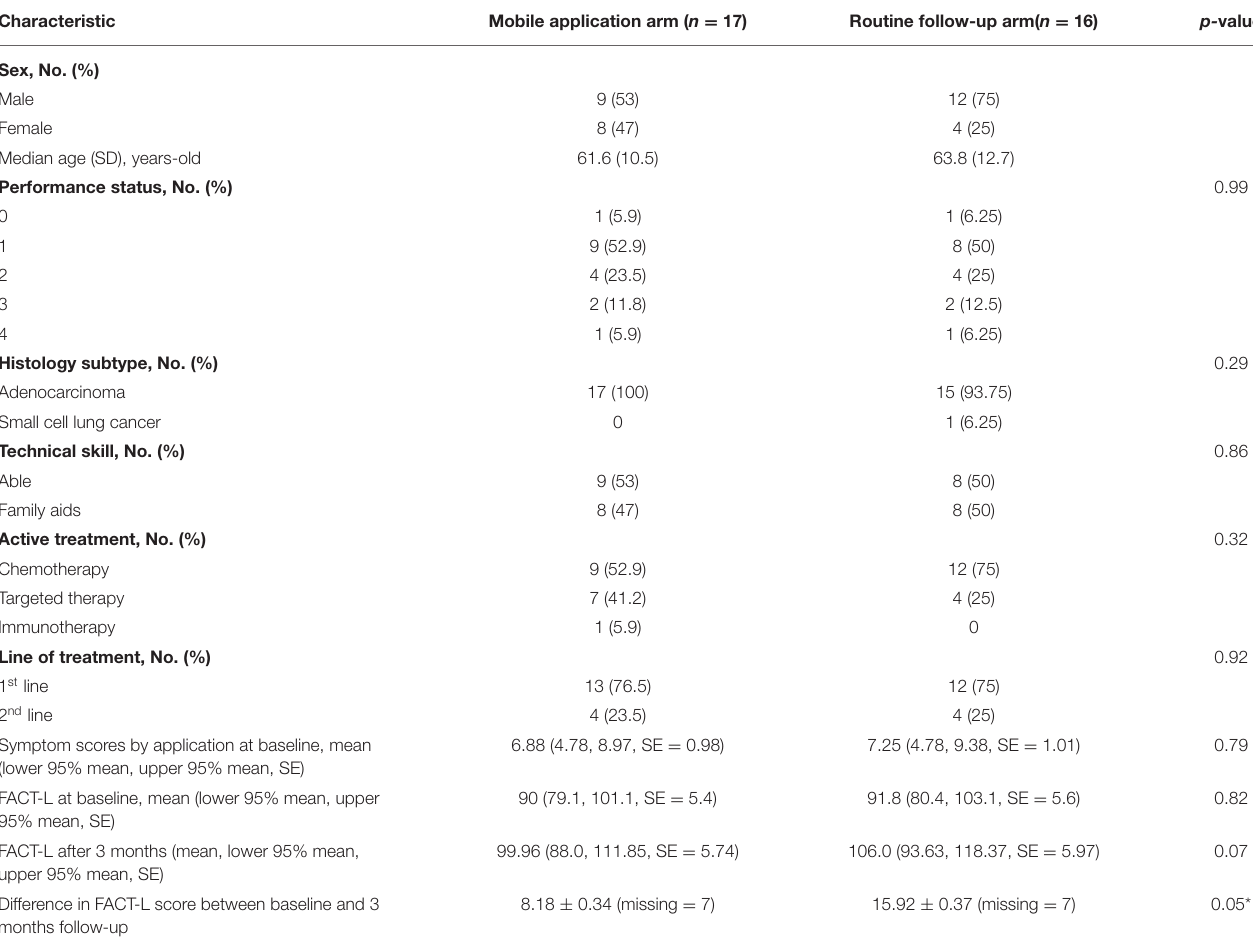
TABLE 2 | Baseline characteristics and Functional Assessment of Cancer Therapy-Lung (FACT-L) scores of both groups.